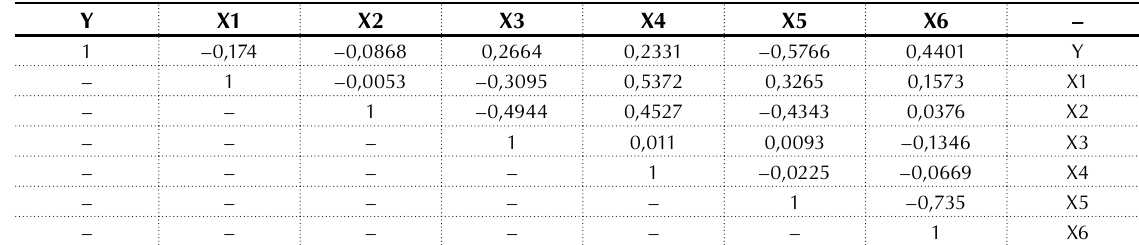
Table A2. Brief statistics of the regression model of the efficiency of tax